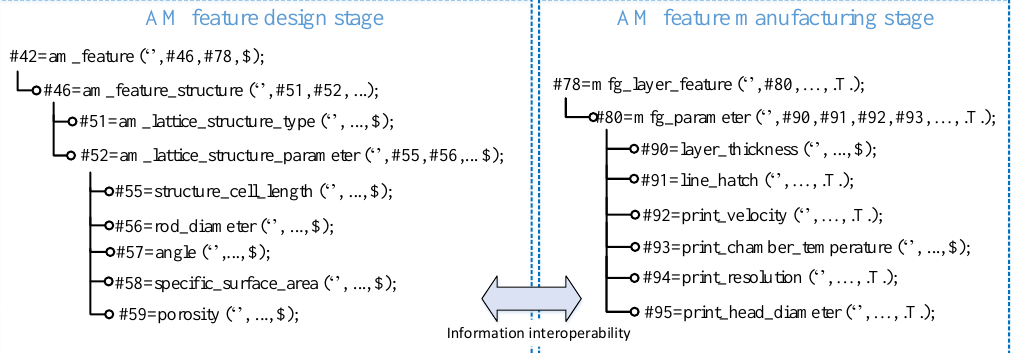
Figure 6. STEP physical file for AM feature design and manufacturing